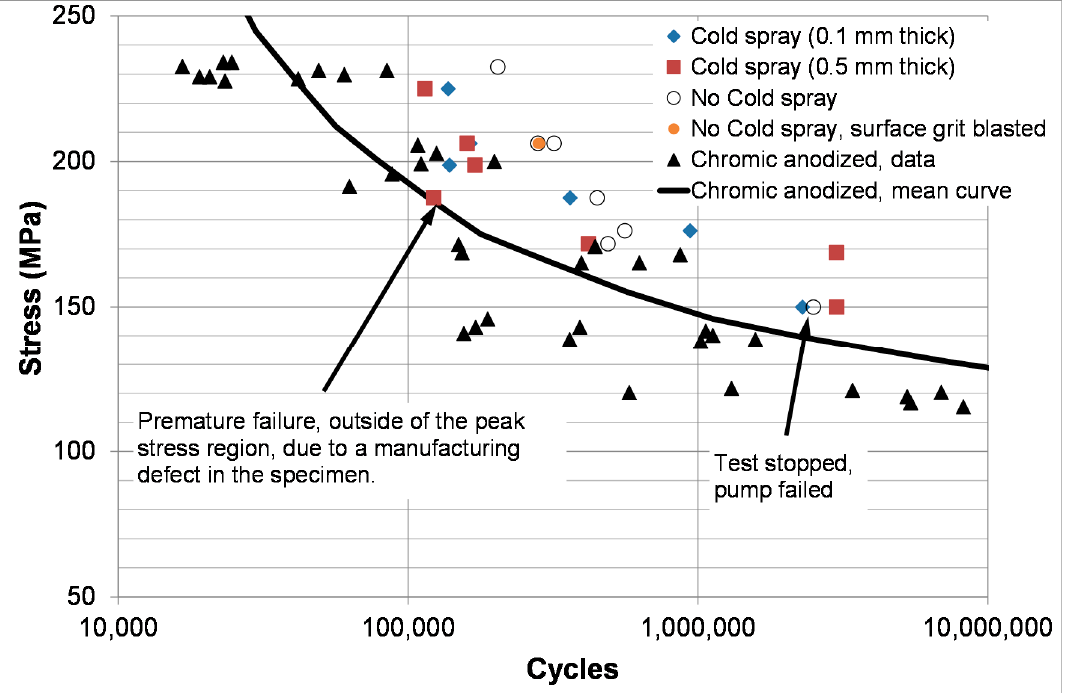
Figure 4. The stress life data associated with the tests on a 2024-T3 skin with a 7075 powder coating.